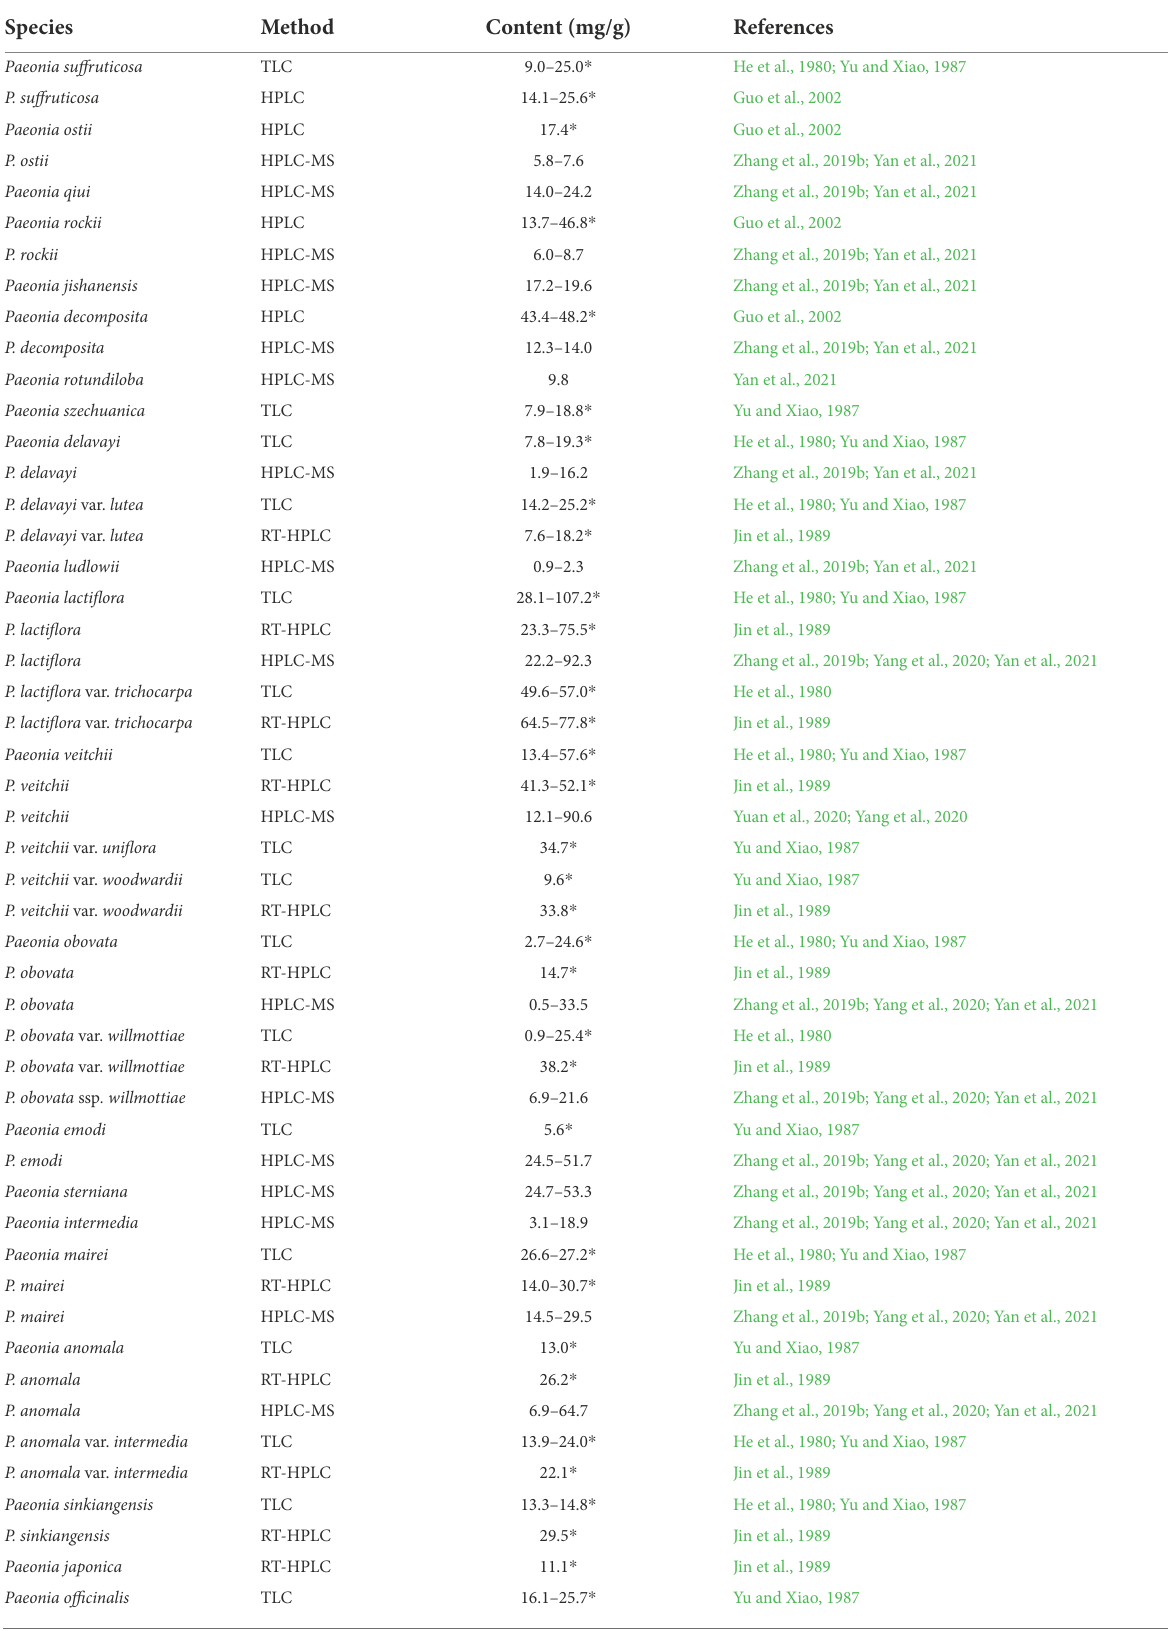
TABLE 1 Paeoniflorin content in the roots of different species belonging to